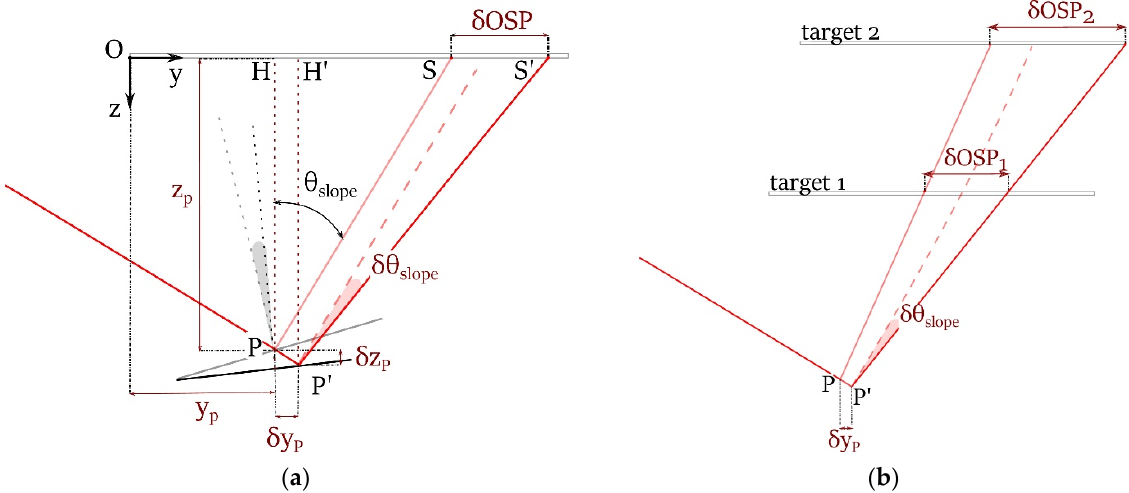
Figure 3. ( a ) Relationship between coordinate errors, slope error, and OSP displacement. Point P lies on the ideal surface, while P’ lies on the real surface. ( b ) Comparison of the slope errors with two different distances between the target and the reflecting surface.